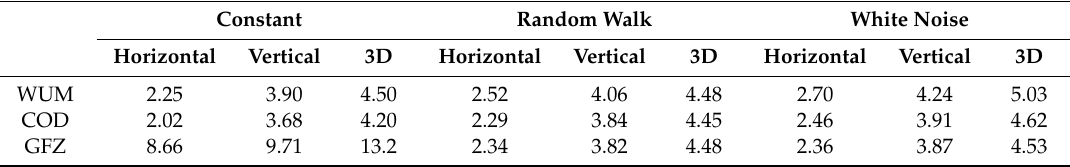
Table 5. RMS (cm) of GPS / BDS PPP result among di ff erent ISB modeling with di ff erent precise